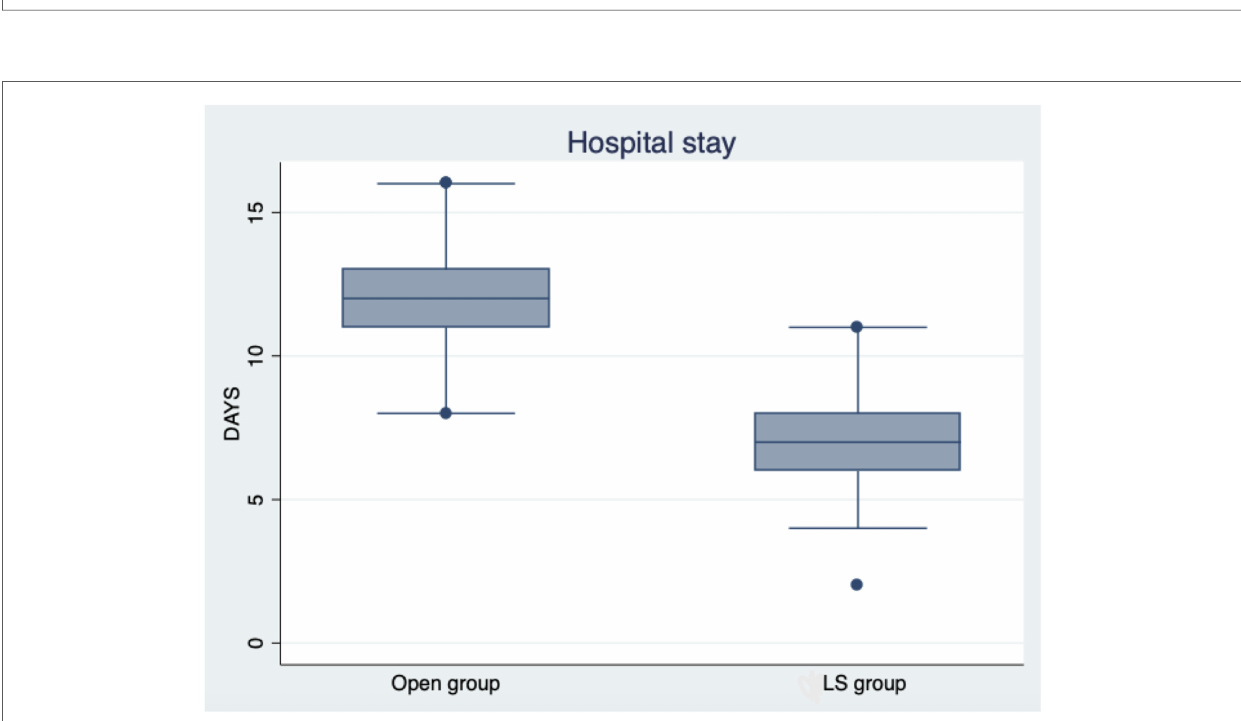
FIGURE 4 Percentage of men and women in the